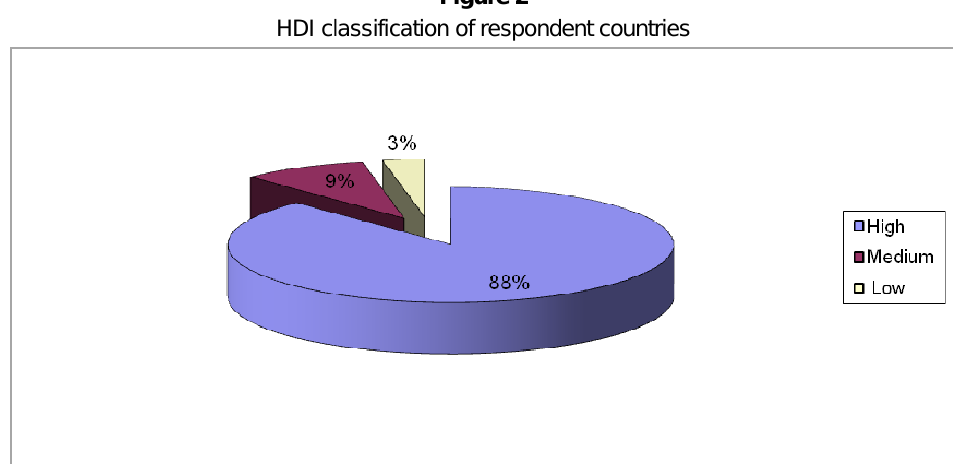
HDI classification of respondent